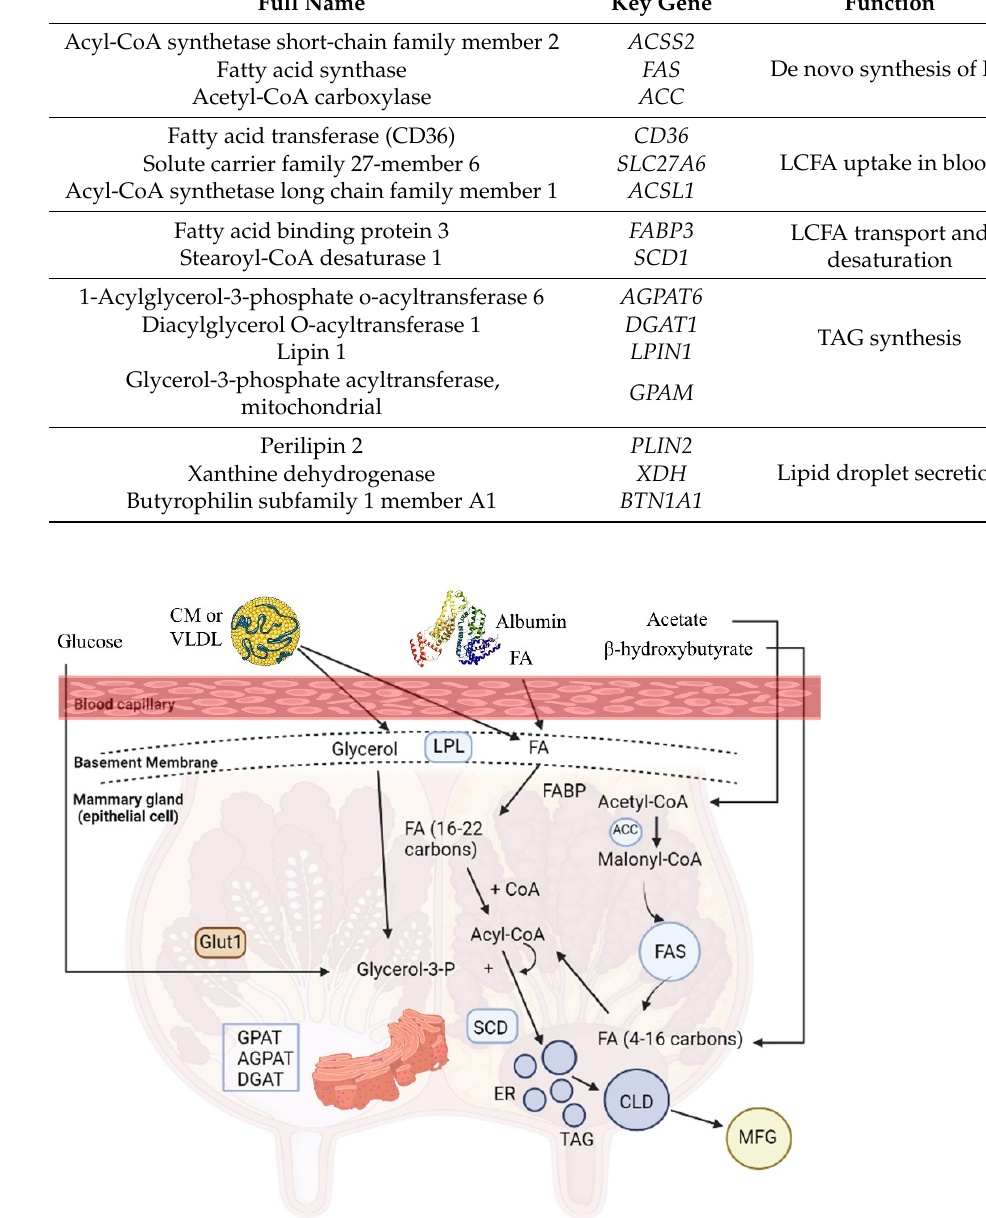
Figure 1. Milk fat synthesis in the ruminant mammary epithelial cell [15]. Abbreviations: ACC = acetyl-CoA carboxylase; AGPAT = acyl glycerol phosphate acyl transferase; CD36 = fatty acid transferase (CD36); CLD = cytoplasmic lipid droplet; CoA = coenzyme A; CM = chylomicron; DGAT = diacylglycerol acyltransferase; ER = endoplasmic reticulum; FA = fatty acid; FABP = fatty acid binding protein; FAS = fatty acid synthase; Glut1 = glucose transporter1; GPAT = glycerol-3 phosphate acyltransferase; LPL = lipoprotein lipase; MFG = milk fat globule; SCD = stearoyl-CoA desaturase;